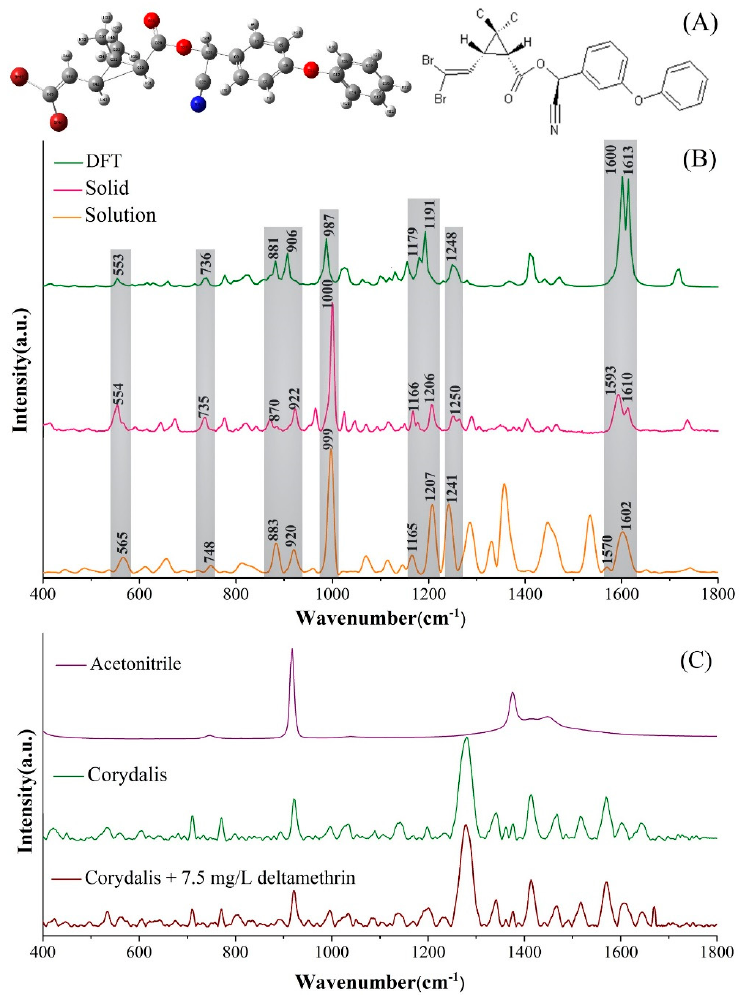
Figure 1. Raman peak assignment of deltamethrin. ( A ) molecular structure of deltamethrin; ( B ) Comparison of Raman spectrum simulated by density functional theory (DFT), Raman spectrum of deltamethrin solid and surface-enhanced Raman spectroscopy (SERS) spectrum of 10 mg / L deltamethrin acetonitrile solution; ( C ) SERS spectra of acetonitrile, extract of no-treatment Corydalis and extract of 7.5 mg / L deltamethrin-containing Corydalis .